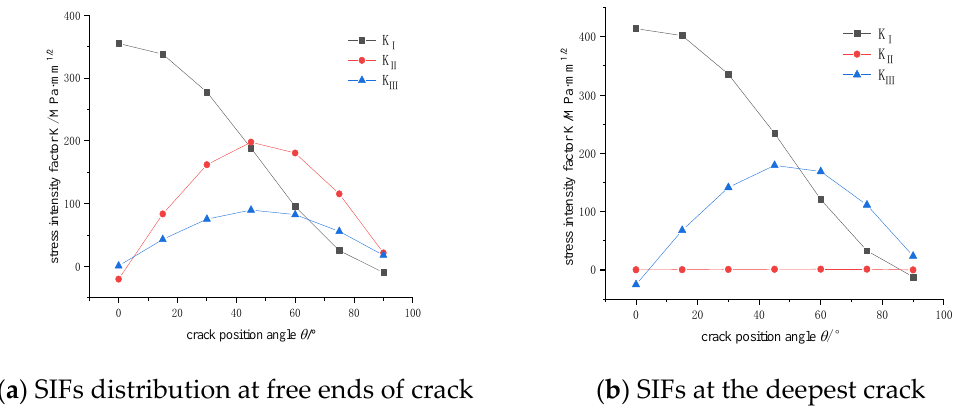
Figure 8. Stress intensity factor distribution of cracks: ( a ) SIFs distribution at free ends of crack ( b ) SIFs at the deepest crack.